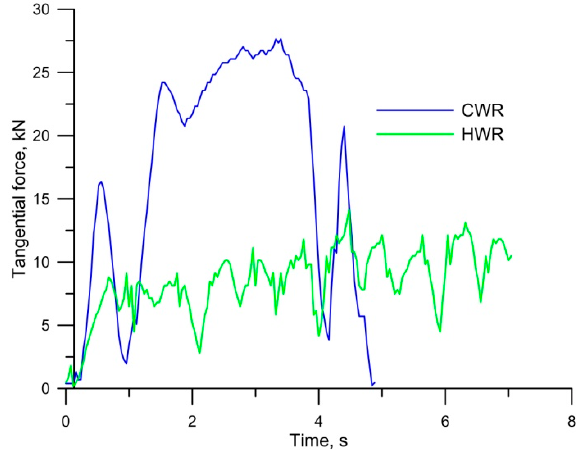
Figure 11. Comparison of tangential force for cross-wedge rolling (CWR) and helical-wedge rolling (HWR).